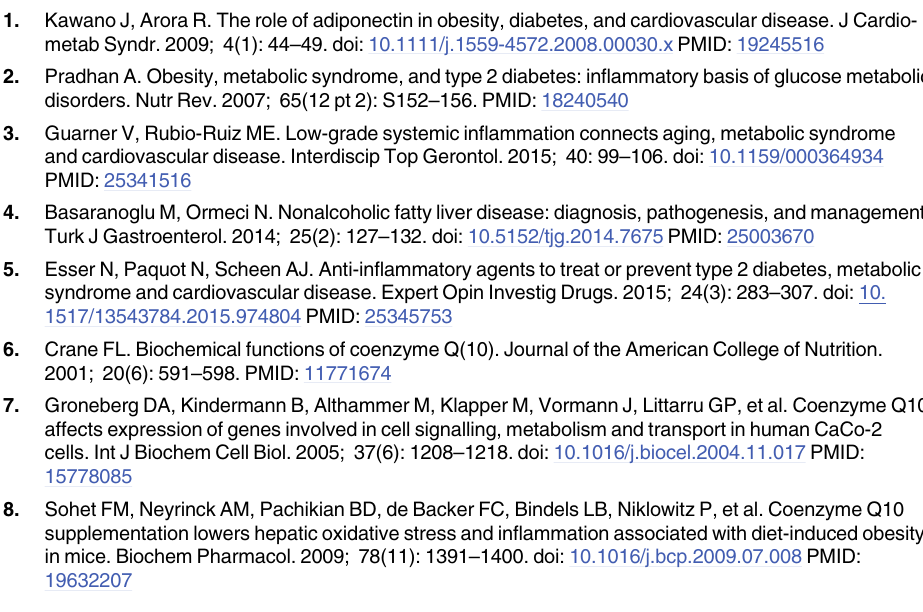
S1 Fig. Funnel plot for publication bias of Coenzyme Q10 supplementation and serum lip- ids (outcomes: A: serum Coenzyme Q10, B: tumor necrosis factor-alpha, C: interleukin-6, D: C reactive